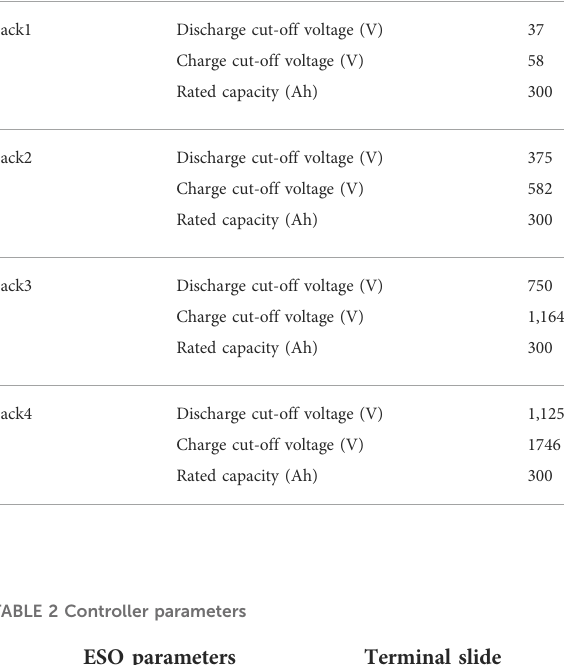
TABLE 1 Parameters for each Pack module of the